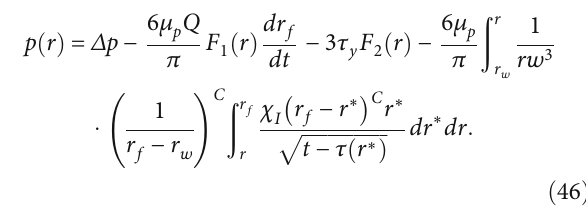
ffiffiffiffiffiffiffiffiffiffiffiffiffiffiffiffiffi p t − τ r ∗ ð Þ